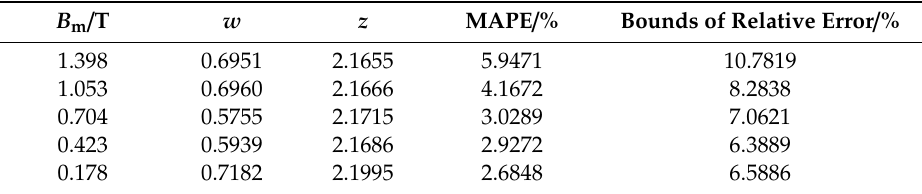
Table 2. Values of parameters and error extracted by hybrid algorithm of PSO–Powell.